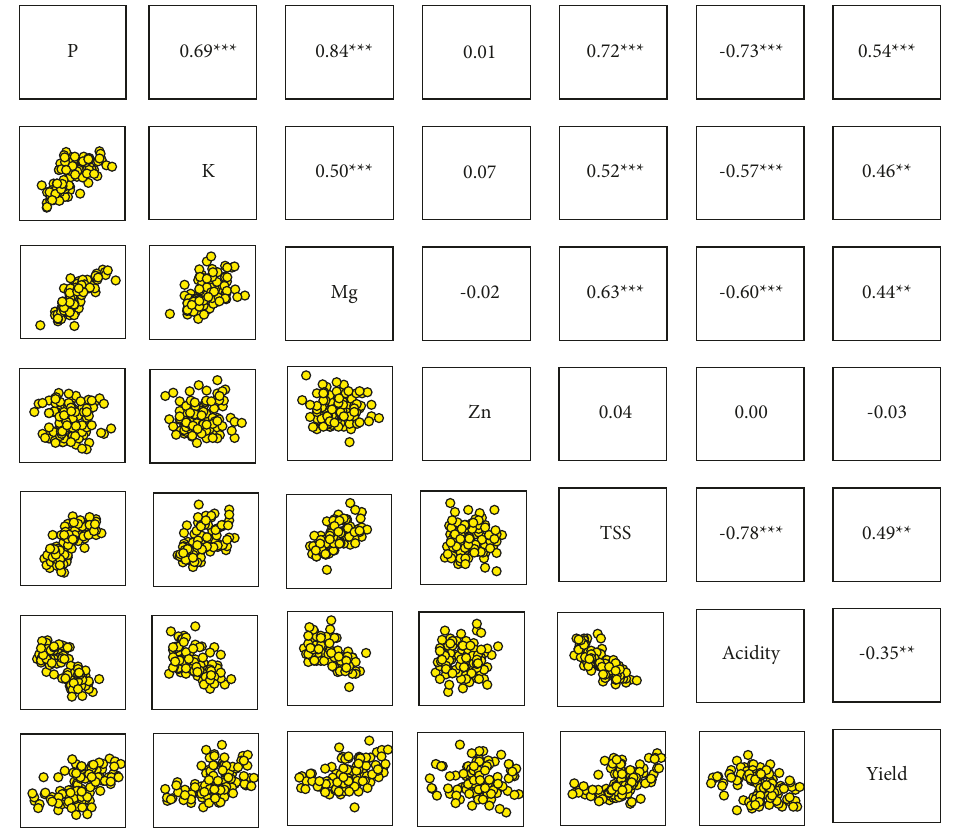
Figure 2: Correlation coefficient matrix of the leaf mineral nutrients, fruit quality, and